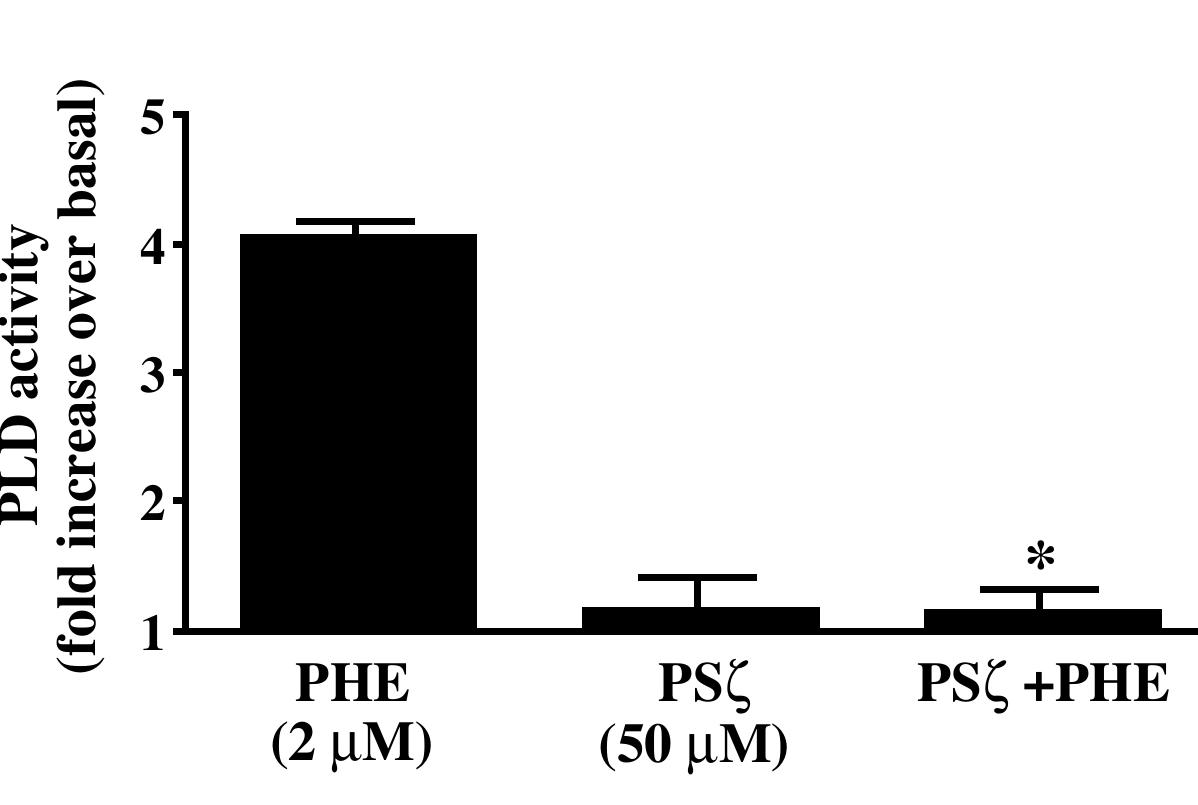
Figure 8 Effect of the pseudosubstrate peptide inhibitor of PKC ζ (PS ζ ) on PLD activity. Cells were pretreated with 50 µ M myristoylated PS ζ for 1 hour before the addition of 2 µ M PHE for 15 min. PLD activity was then measured as described in Methods. Data are expressed as the fold increase in PLD activity above basal (untreated cells). * Value significantly different from PHE alone, p <